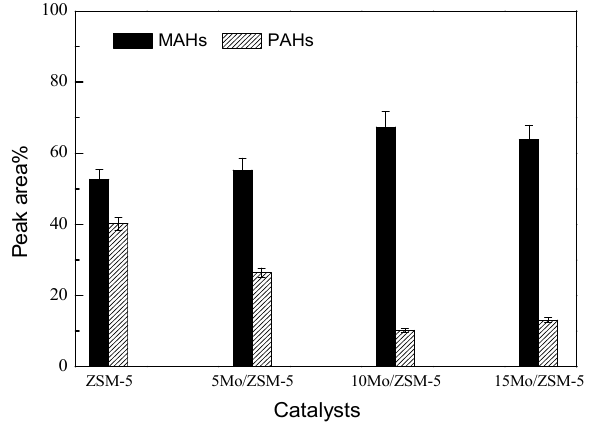
Figure 4. Distribution of aromatics produced from catalytic fast pyrolysis (CFP) of biomass over different catalysts (T = 600 °C, catalyst/biomass mass ratio = 10).